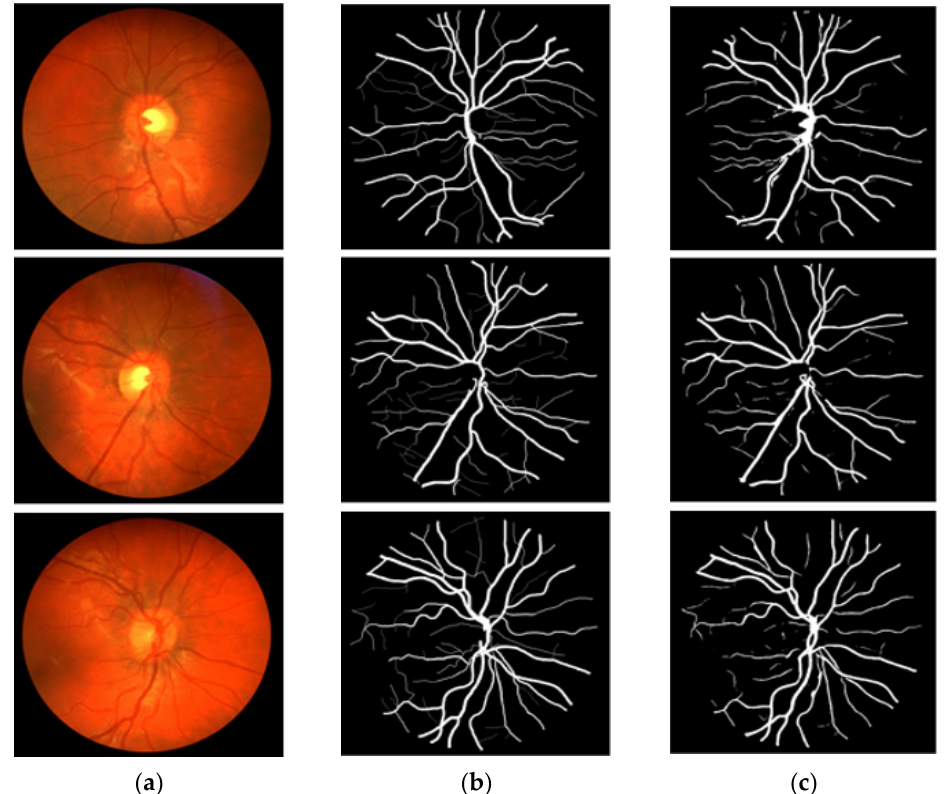
Figure 11. Visual results of the proposed DSA-Net using CHASE-DB1: ( a ) Original input image, ( b ) Expert annotation, and ( c ) Predicted image mask by